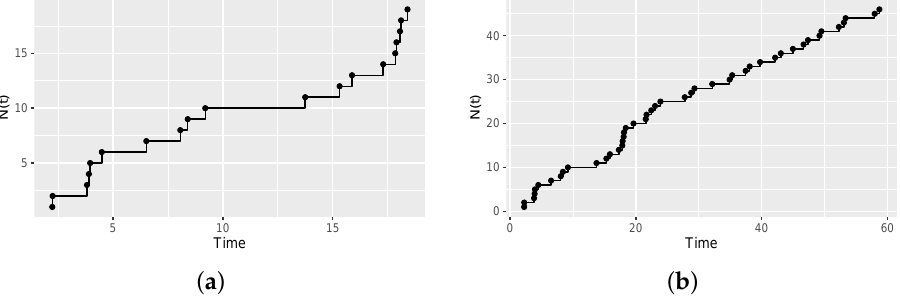
Figure 5. Simulation of a Cox process with Folded Normal intensity function with parameters µ = 0, σ 2 = 1 and with covariance function k Z ( h ) = I { 0 } ( h ) for T = 20 ( a ) and T = 60 ( b ).